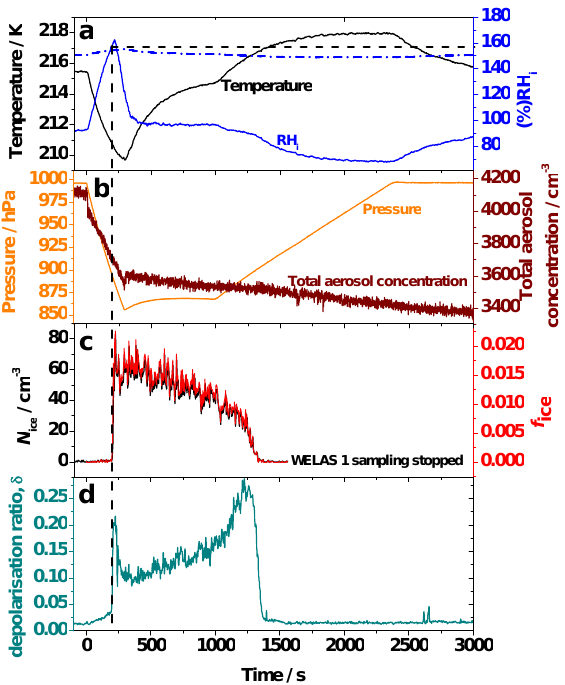
Fig. 5. A typical expansion experiment at the AIDA chamber using liquid aqueous raffinose/M5AS aerosol. Panel (a) shows the temper- ature and RH i (solid black and blue lines) as well as the expected homogeneous freezing RH i (dash-dot blue line), based on AIDA homogeneous freezing data from liquid aqueous H 2 SO 4 aerosol (M¨ohler et al., 2003). Panel (b) shows the pressure and total aerosol concentration (orange and burgundy lines). The ice particle number concentration from WELAS 1 and the fraction of aerosol that froze are shown in (c) (black and red lines). In (d) , the onset of ice nucle- ation is seen as the sharp rise in δ (cyan line). The time/humidity at the onset of freezing is marked with dashed black